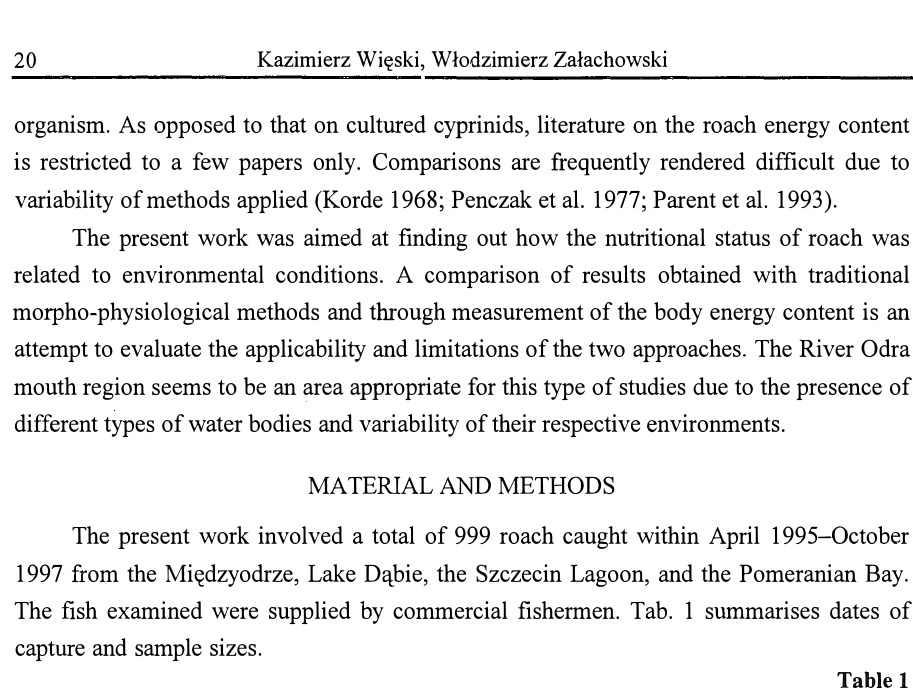
Date of capture and number of individuals